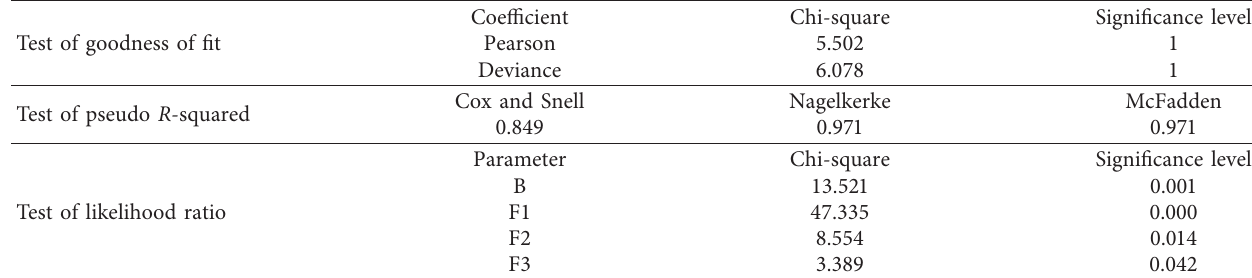
Table 8: The test of the logistic regression model.